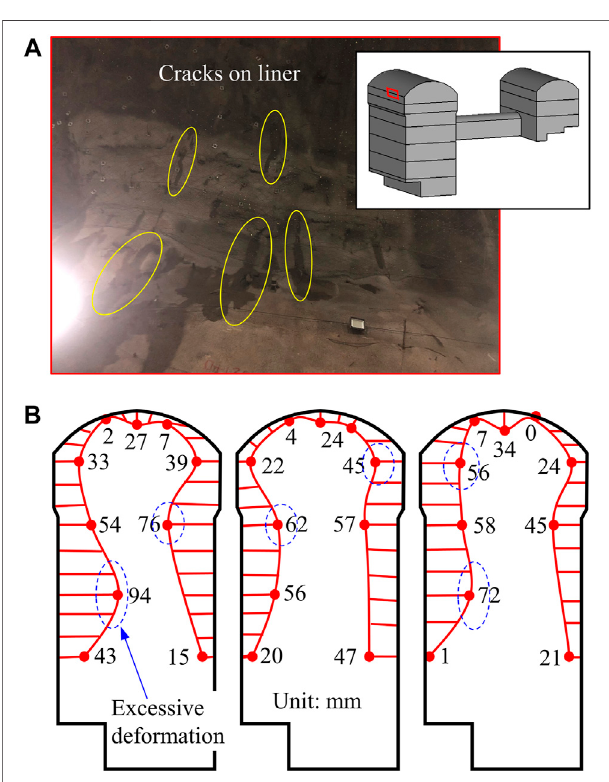
FIGURE 8 | Cracked liner (A) and monitored deformation (B) of the